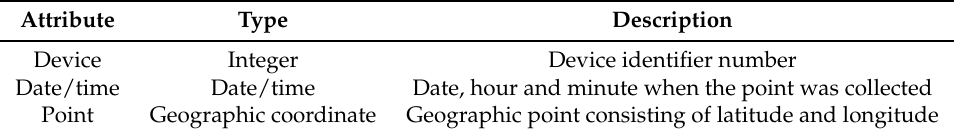
Table 1. Collected points: Algorithm 1 (detection of pairs) input.